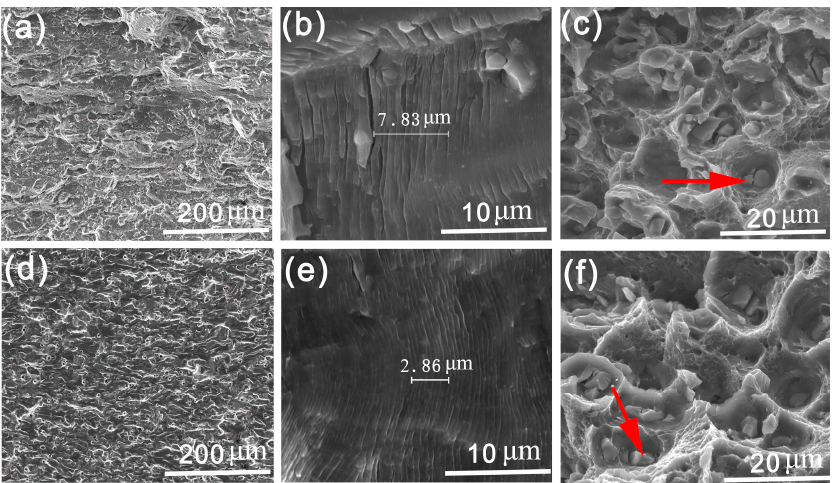
Figure 4. Microstructure of fatigue fracture surfaces in different stages for sample A ( a – c ) and sample B ( d – f ).